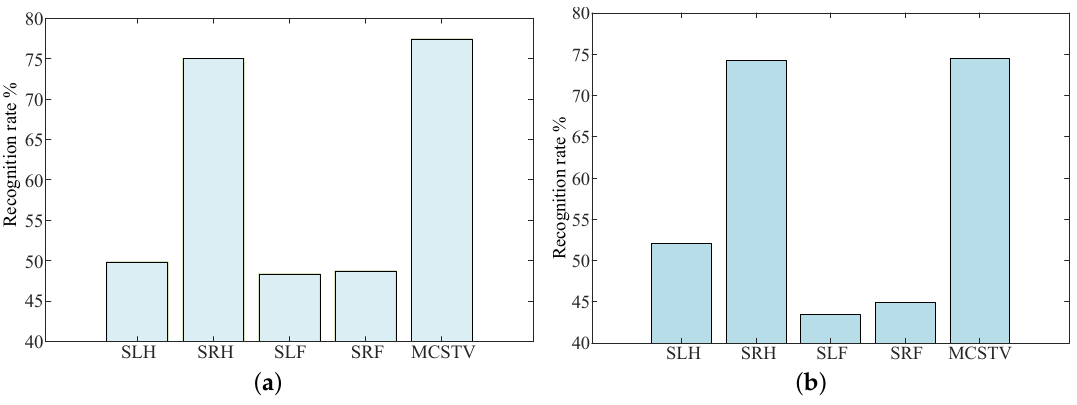
Figure 12. The recognition rate of different movement features. ( a ) The results on MSR-Action3D; ( b ) The results on